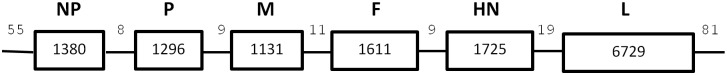
Schematic diagram showing the genomic organization of novel APMV.